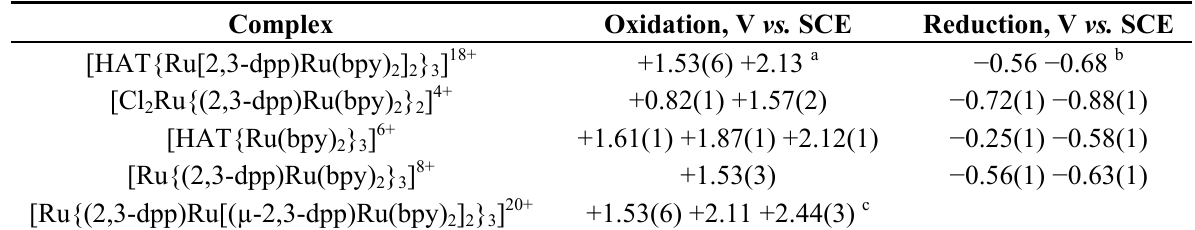
Table 11. Redox potentials for polynuclear complexes in acetonitrile vs. SCE